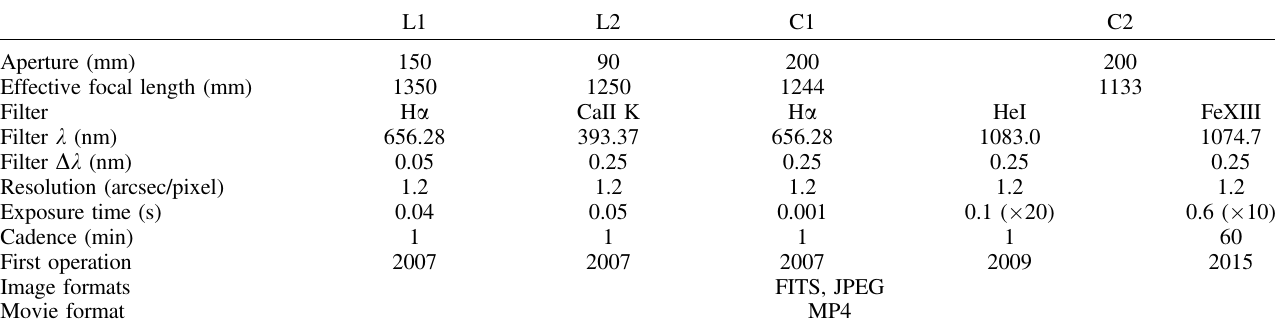
Table 1. Overview of CLIMSO instrumentation and